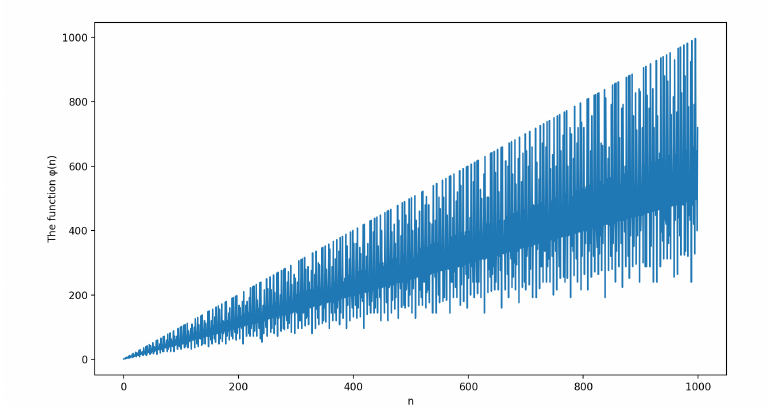
Figure 2. The first 1000 values of the Euler